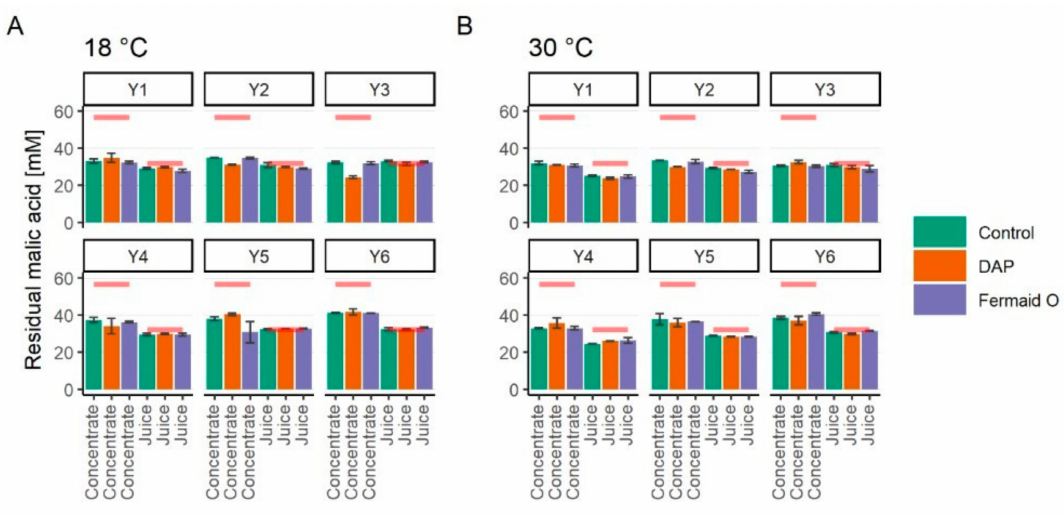
Figure 3. Residual malic acid concentration at the end of fermentation ( p < 0.05). The color green represents control samples, orange—supplemented with DAP, purple—supplemented with Fermaid O. ( A ) represents the samples fermented at 18 ◦ C; ( B )—at 30 ◦ C. Red lines represent initial malic acid content either in juice or reconstituted